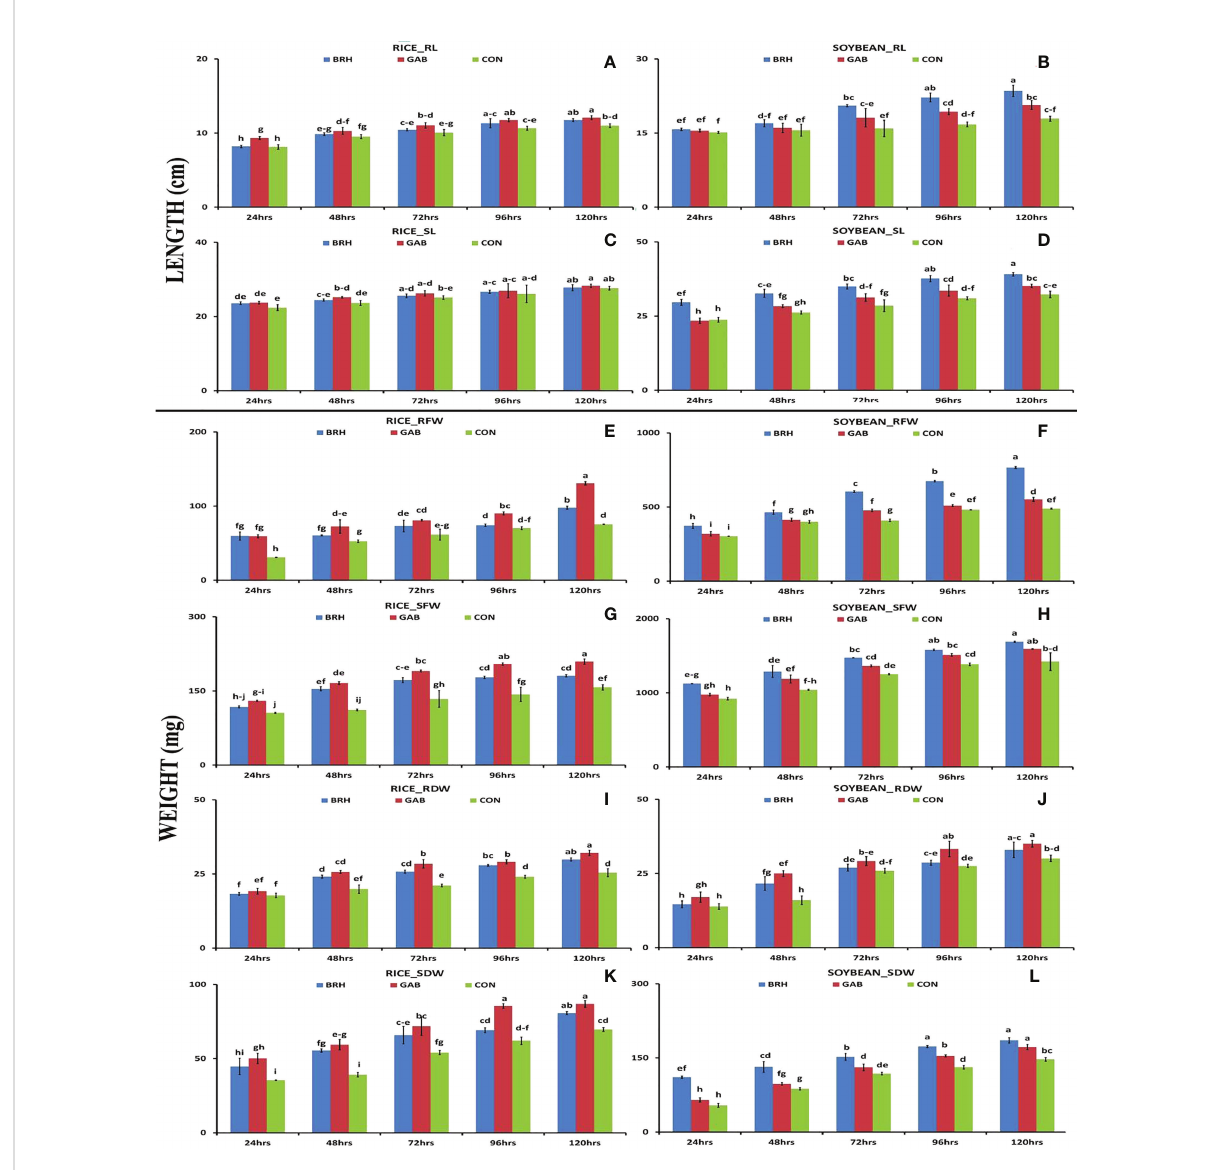
FIGURE 2 Graphs showing the morphological parameters of rice and soybean roots at fi ve time points after inoculation with Gluconacetobacter diazotrophicus (GAB) and Bradyrhizobium japonicum (BRH). (A) Rice_RL (root length); (B) Soybean – RL; (C) Rice_SL (shoot length); (D) Soybean_SL; (E) Rice_RFW (root fresh weight); (F) Soybean_RFW; (G) Rice_RDW (root dry weight); (H) Soybean_RDW; (I) Rice_SFW (shoot freshweight); (J) Soybean_SFW; (K) Rice_SDW (shoot dry weight); (L) Soybean_SDW. Small letter on the top of the bar indicates the critical differences. Same letters indicate statistically non-signi fi cant and different letters indicate statistically signi fi